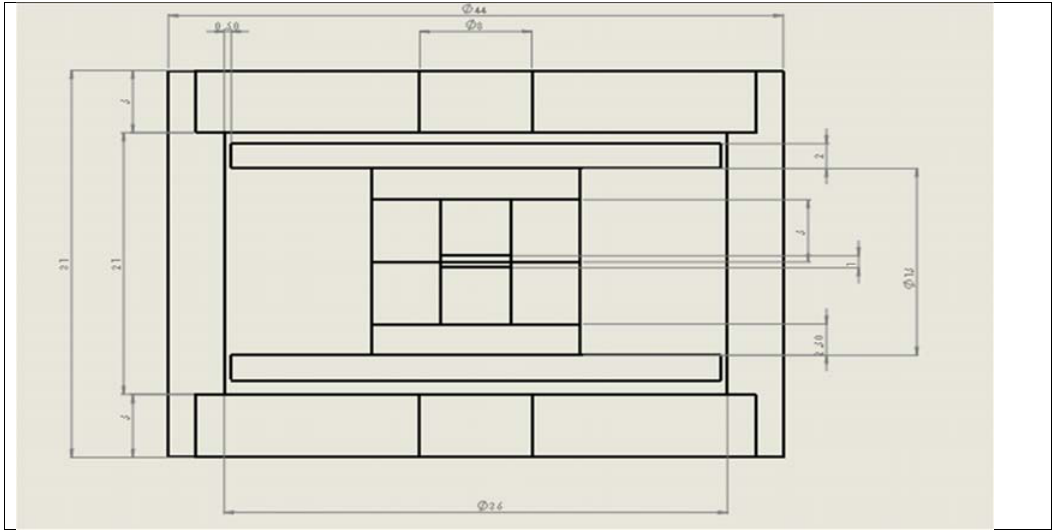
Fig. 2. The Dimension (in mm) of the MR valve.